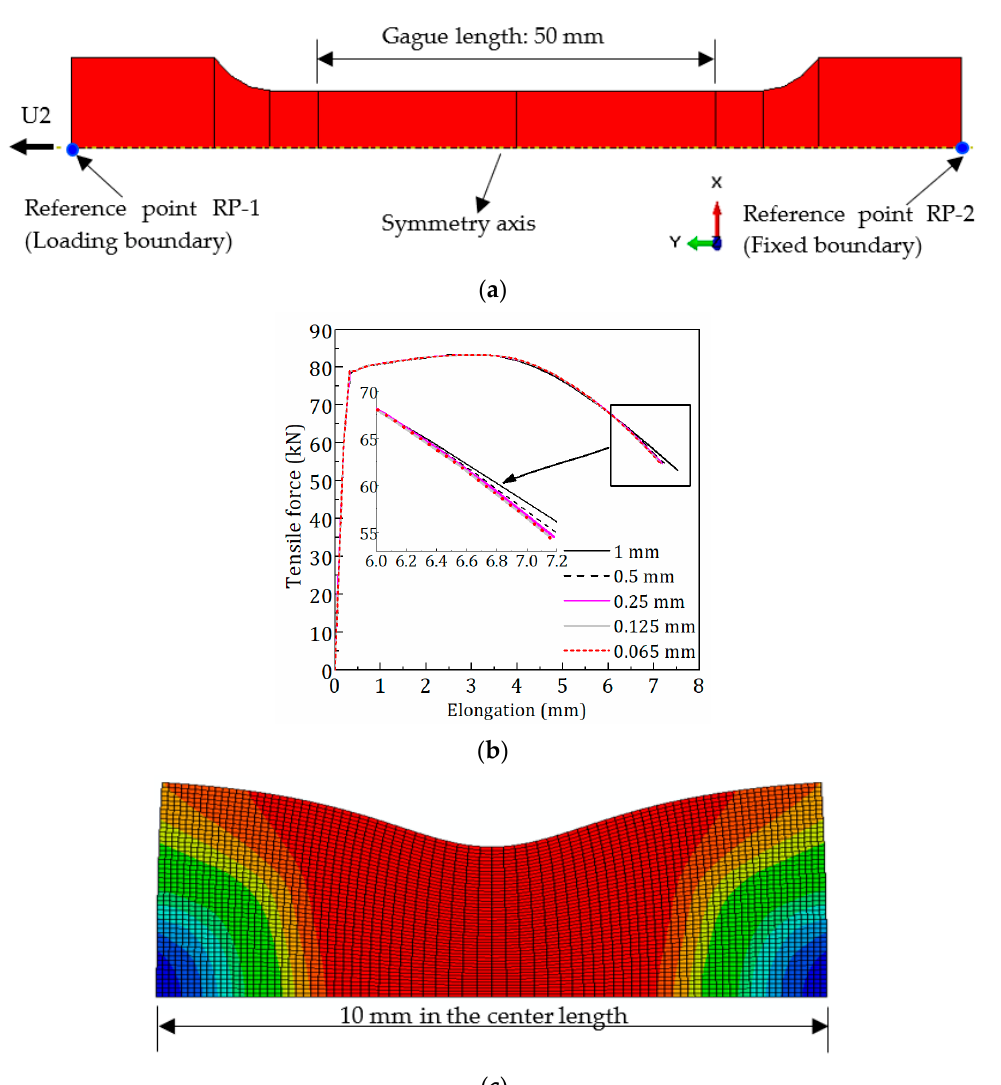
Figure 6. Axisymmetric finite element model of uniaxial tensile tests: ( a ) Boundary conditions; ( b ) Mesh convergence analysis; ( c ) Mesh (size: 0.125 mm).